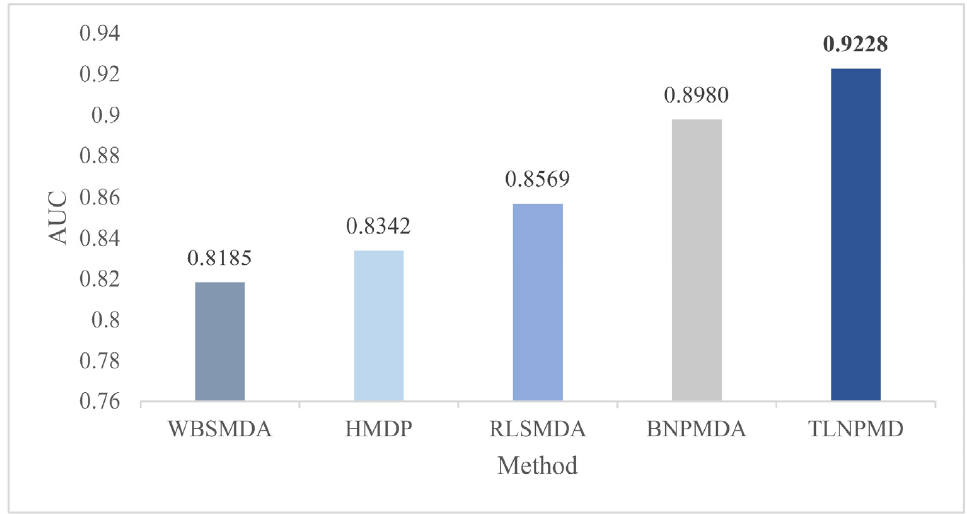
Figure 1. Results of compared models in terms of FCV.